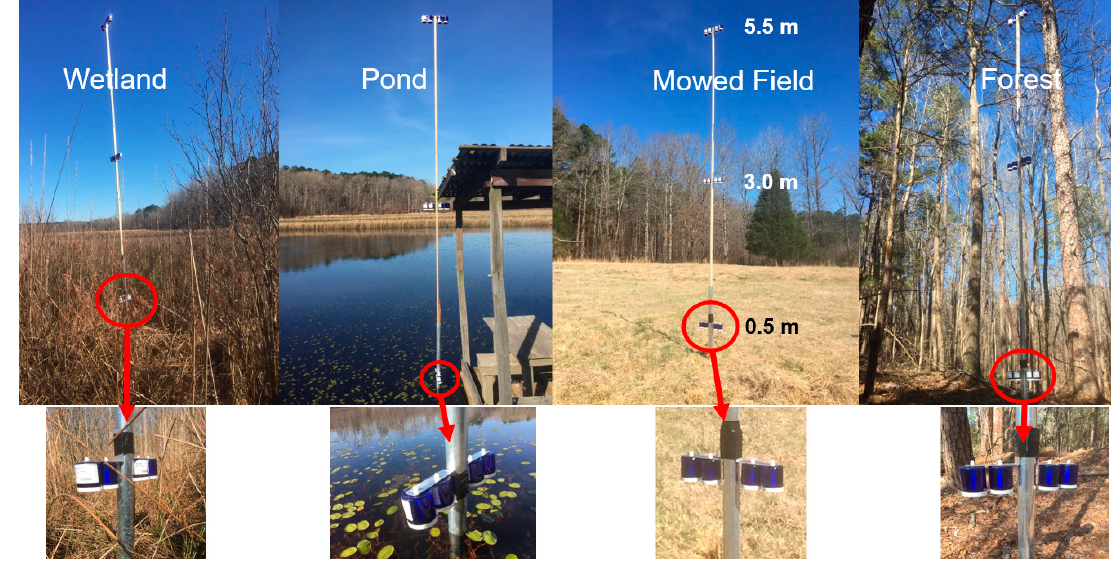
Figure 3. Deployment of Hg passive air samplers at the University of Mississippi Field Station during winter 2019.